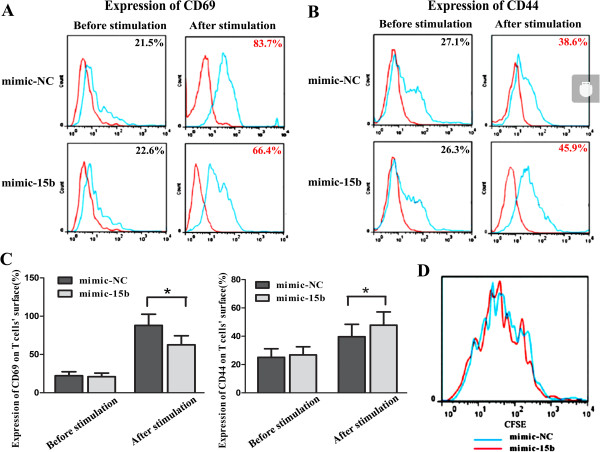
miRNA-15b regulates phenotypes of CD8+ T cell but does not affect proliferation of T cell. A) After transfected with mimic-15b or mimic-NC, CD8+ T cells were co-stimulated by CD3/CD28 mAb. The expression of CD69 before or 48 h after co-stimulation was detected by flow cytometry analysis. The red line represented an isotype-matched control. The blue line represented the staining of CD69 mAb conjugated with APC. B) The expression of CD44 before or 120 h after co-stimulation was detected by flow cytometry analysis. The red line represented an isotype-matched control. The blue line represented the staining of CD44 mAb conjugated with PE. C) Before and after co-stimulation by CD3/CD28 mAb, the positive rates of CD69 (left) or CD44 (right) in CD8+ T cells with mimic-15b or mimic-NC were evaluated. The data were obtained from three independent experiments (mean ± standard deviation), *P < 0.01. D) CFSE-dilution analysis on CD8+ T cells transfected with mimic-15b or mimic-NC after 96 h of co-stimulation with CD3/CD28 mAb. Red line represented T cells with mimic-15b and blue line represented T cells with mimic-NC.